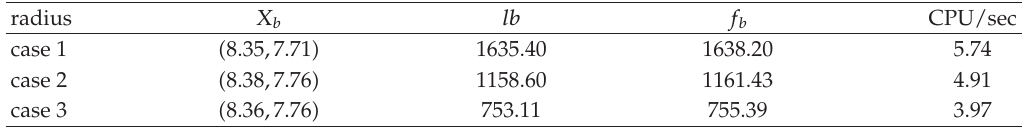
Table 3: The results of Example